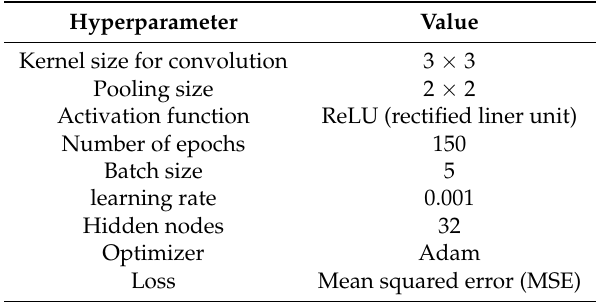
Table 1. Hyperparameter values used in the proposed model.